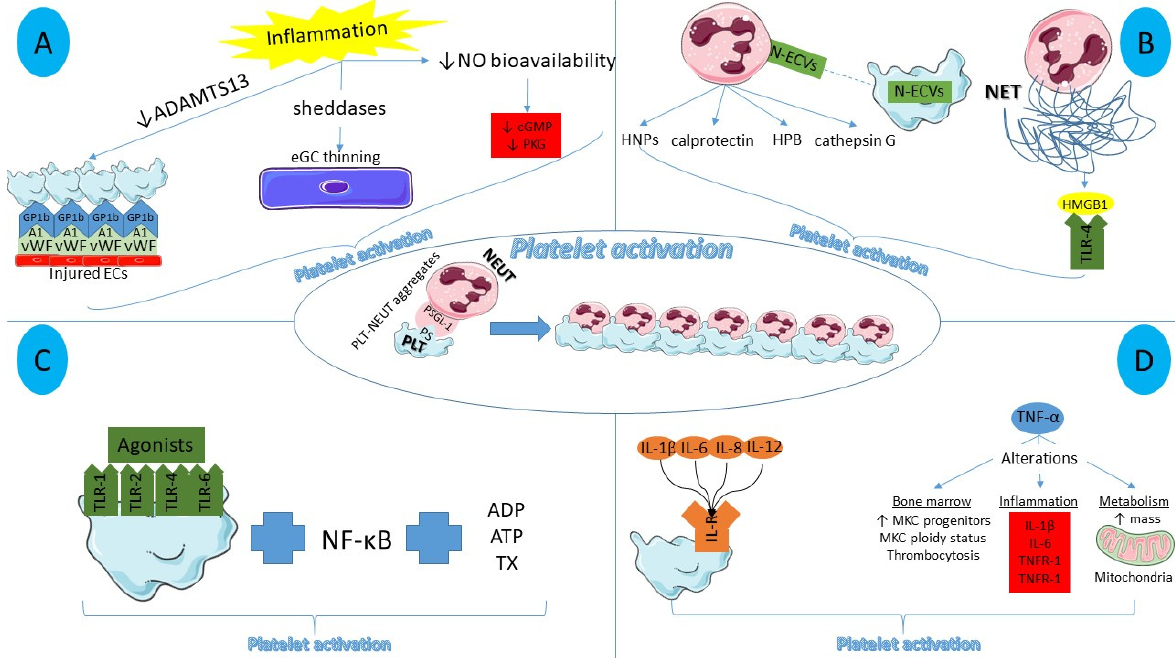
Figure 1. Main inflammatory mediators of platelet activation. ( A ) Endothelial dysfunction in the setting of inflammation results in increased platelet–endothelial cell interactions, thinning of endothelial glycocalyx, and reduced nitric oxide bioavailability, contributing to platelet activation. ( B ) Neutrophil-derived molecules and extracellular vesicles aid platelet activation, together with the pro-thrombotic role of NET histones via a Toll-like receptor 4-related platelet activation. ( C ) Platelet toll-like receptors cannot directly induce platelet activation but they augment it, stimulated by NF- κ B, thromboxane, adenosine diphosphate, and adenosine triphosphate. ( D ) Pro-inflammatory interleukins bind to interleukin receptors situated on the platelet surface while tumor necrosis factor-alpha promotes alterations in bone marrow, inflammation, and mitochondria, collectively facilitating platelet activation. ADAMTS13: A disintegrin-like and metalloprotease with thrombospondin type-1 repeats-13, NO: nitric oxide, EC: endothelial cells, eGC: endothelial glycocalyx, cGMP: cyclic guanyl monophosphate, PKG: protein kinase G, N-ECV: neutrophil extracellular vesicles, HNP: human neutrophil peptides, HBP: neutrophil, PLT: platelet.